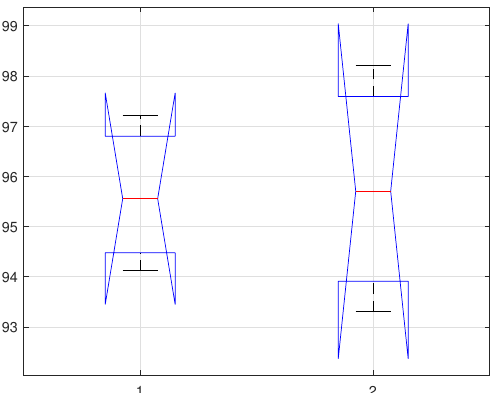
Figure 8. Confidence Interval of selected classifiers using statistical features of fourier descriptors.